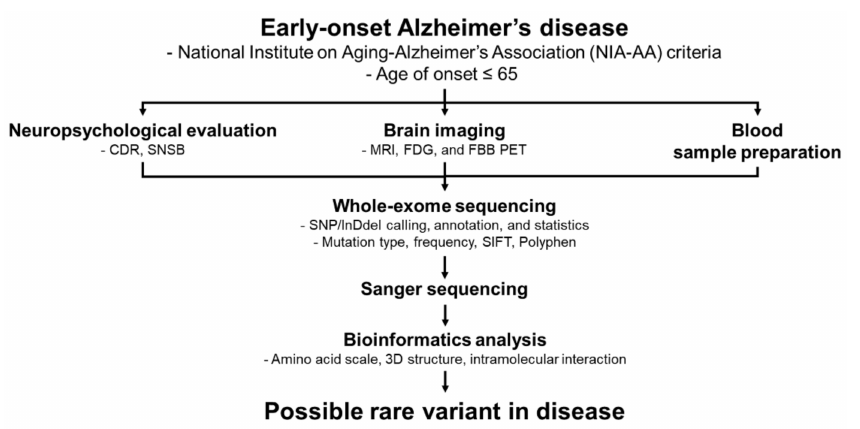
Figure 6. The flow chart describes the major experimental steps from the AD patient to the identifica- tion of